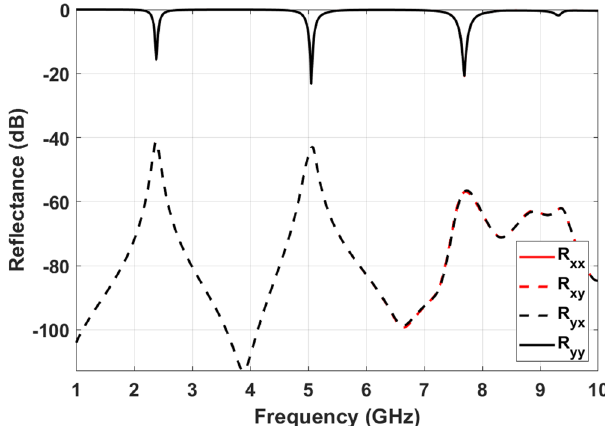
Figure 10. Co- and cross-polarization